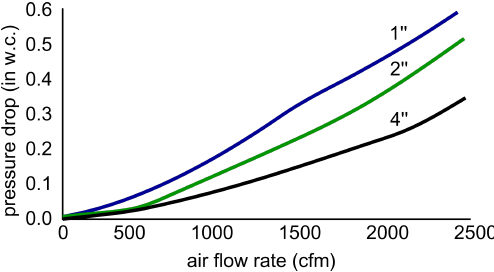
Figure 2. Pressure drop as a function of the air flow rate over the filter domain for three different filter thickness, namely 1 inch (2.54 cm), 2 inches (5.08 cm), and 4 inches (10.16 cm). Source: prepared by the authors with adaption from